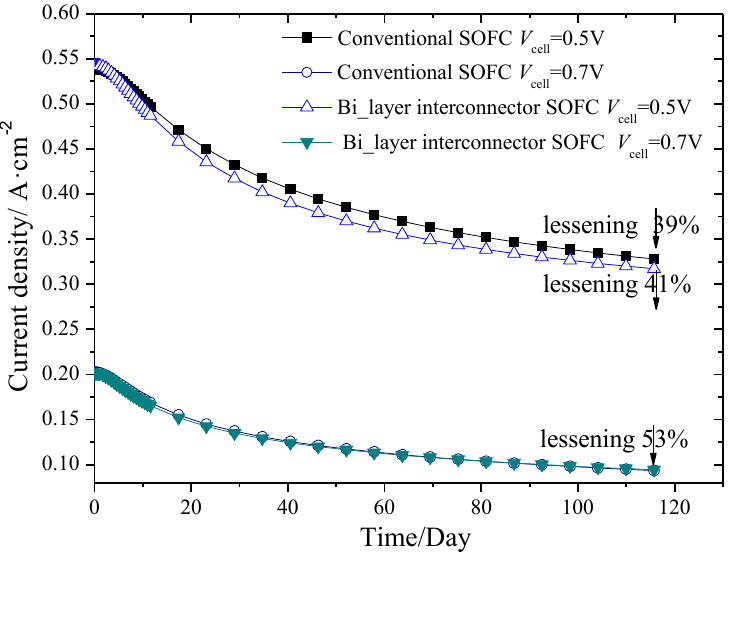
Figure 9. Variation of current density for SOFC models with different